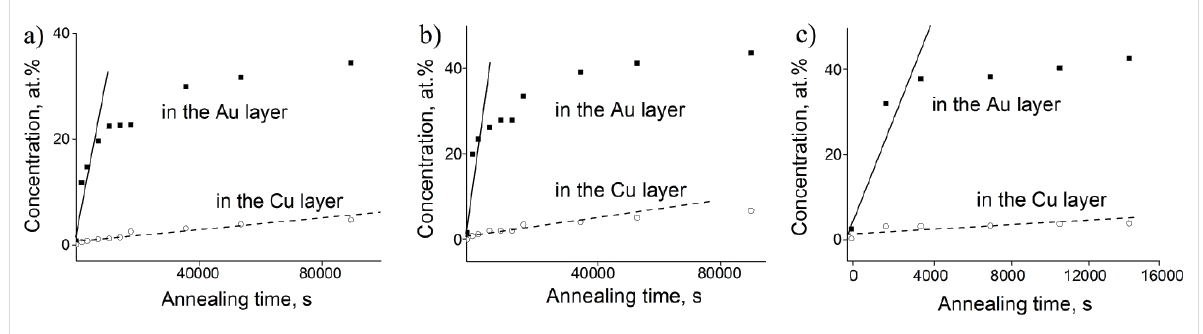
Figure 10: Dependence of the average concentration of elements on the annealing time at 150 °C in a) Au(25nm)/Cu(50nm), b) Au(25nm)/Cu(25nm) and c) Au(25nm)/Cu(12nm)